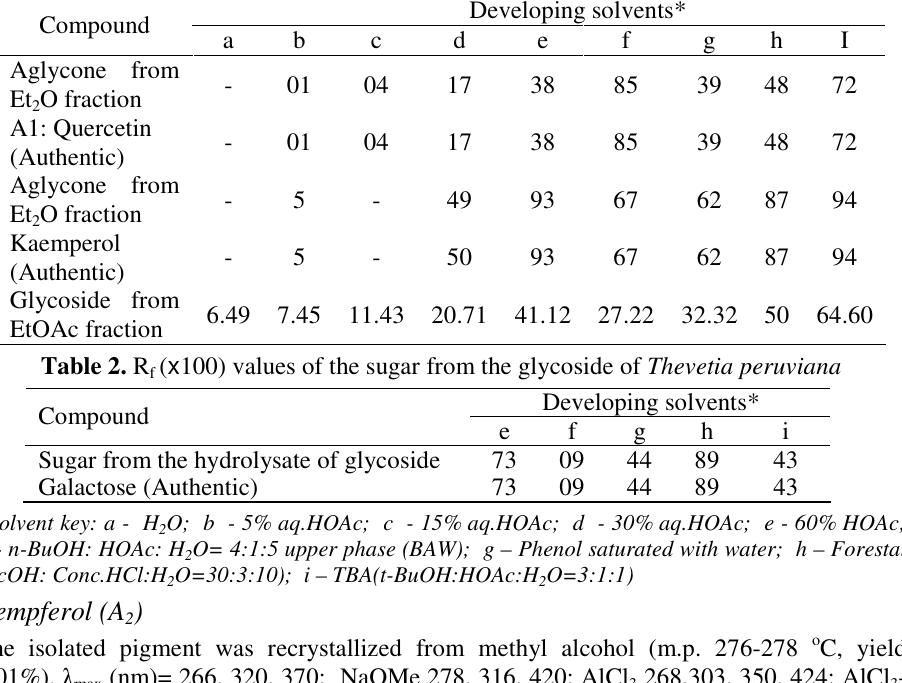
Developing solvents*